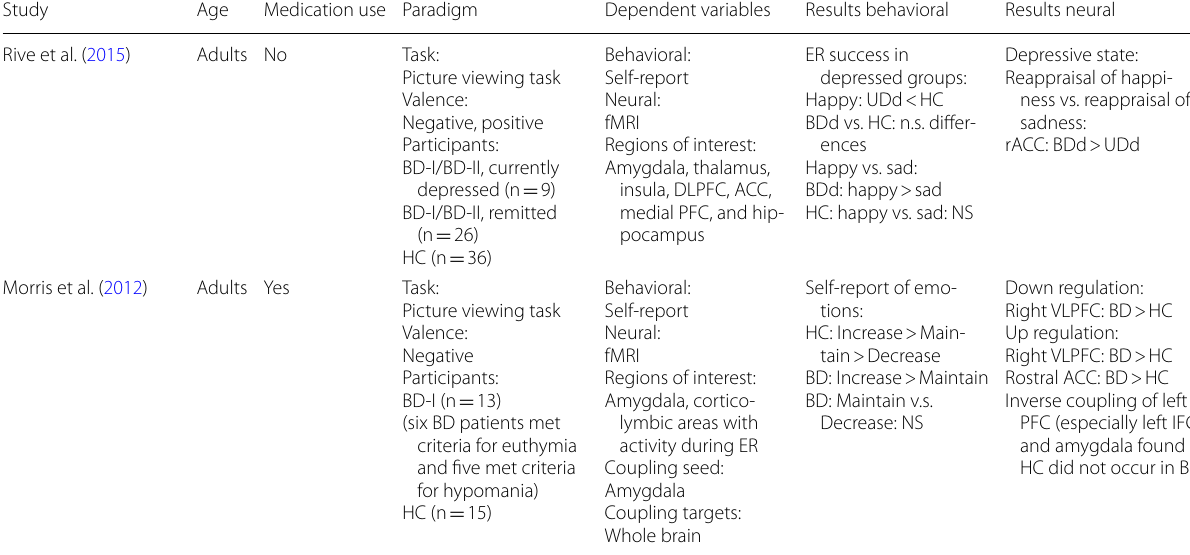
ACC anterior cingulate cortex, BD bipolar disorder, DLPFC dorsolateral prefrontal cortex, fMRI functional magnetic resonance imaging, HC healthy controls, PFC prefrontal cortex, PPI psychophysiological interaction, rACC rostral anterior cingulate cortex